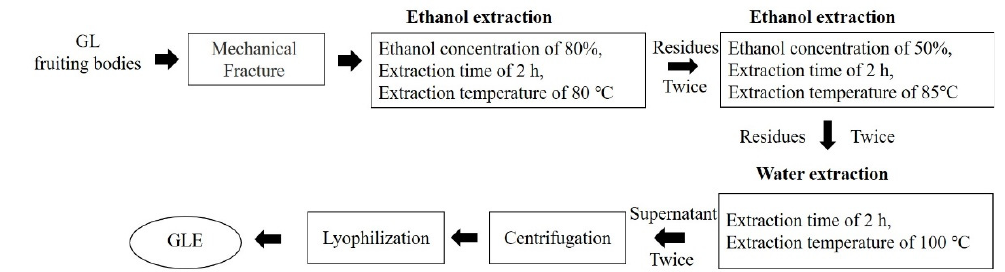
Figure 1. GLE preparation scheme.